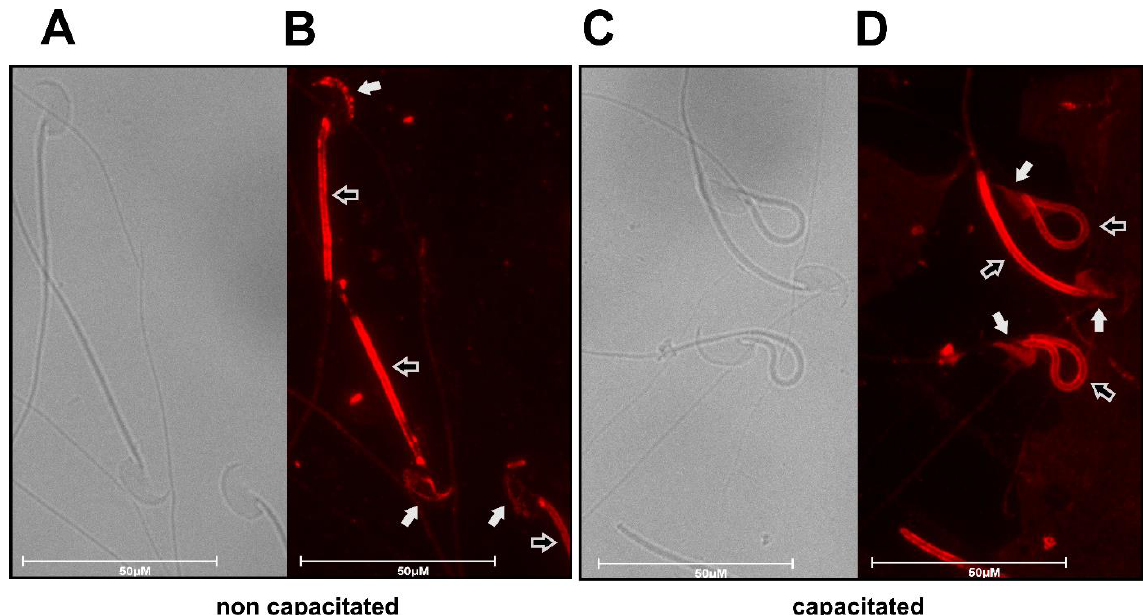
Figure 2. Immunohistochemical Gpx4 staining of wild-type mouse sperm before and after the capacitation. Sperm from epididymal cauda and vas deferens were extracted and capacitated. Immunohistochemical staining was carried out as described in the “Materials and Methods” section. ( A ) Phase contrast visualization of non-capacitated sperm, ( B ) immunohistochemical Gpx4 staining of non-capacitated sperm, 100-fold. Midpiece (white framed arrows) and head (white arrows) were stained Gpx4 positive. 87% of sperm exhibited Gpx4-positive staining of the head. ( C ) Phase contrast visualization of capacitated sperm, ( D ) immunohistochemical Gpx4 staining of capacitated sperm, 100-fold. Midpiece (white framed arrows) and the post-acrosomal region (white arrows) were stained Gpx4 positive, whereas the anterior region of the sperm head was devoid of Gpx4. 73% of sperm exhibited Gpx4 positive staining of the post-acrosomal region.